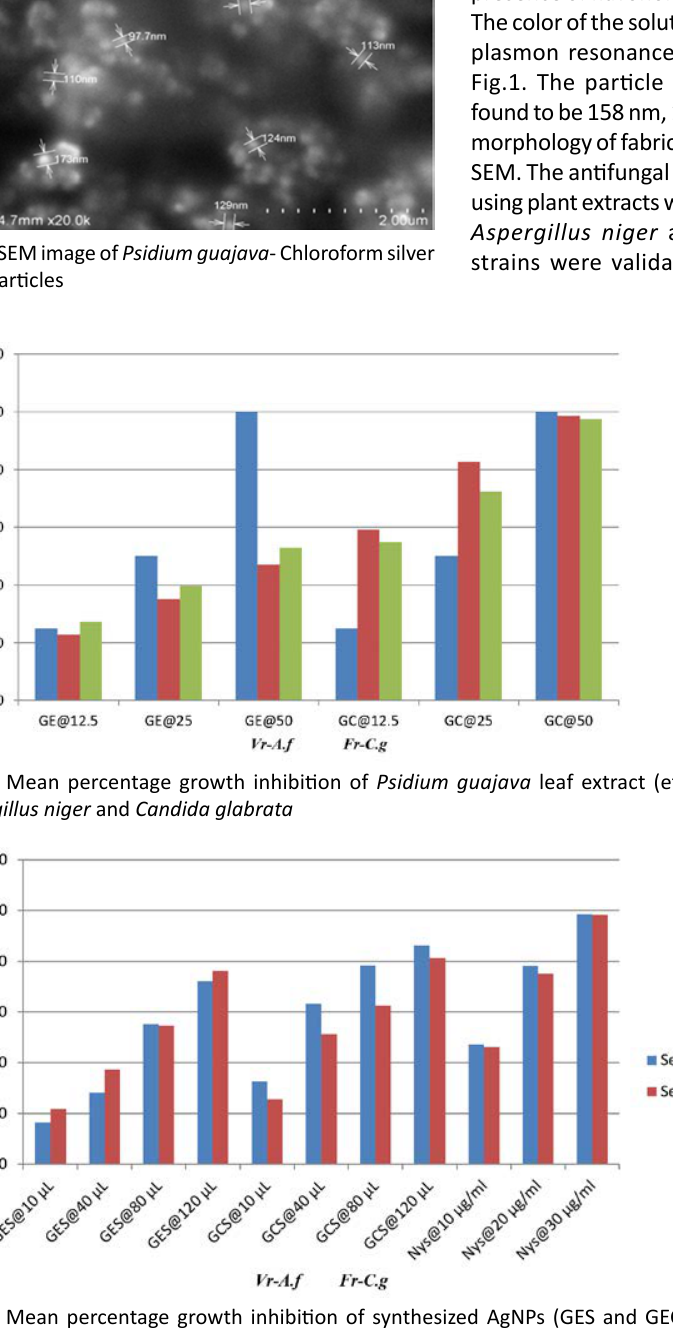
Fig. 9. Mean percentage growth inhibition of synthesized AgNPs (GES and GEC) against Aspergillus niger and Candida